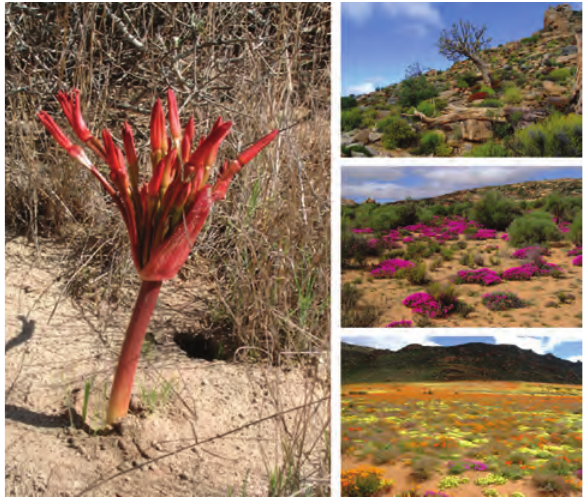
South Africa harbours a wealth of floristic diversity. The Cape Floristic Biome alone has over 6000 endemic plant